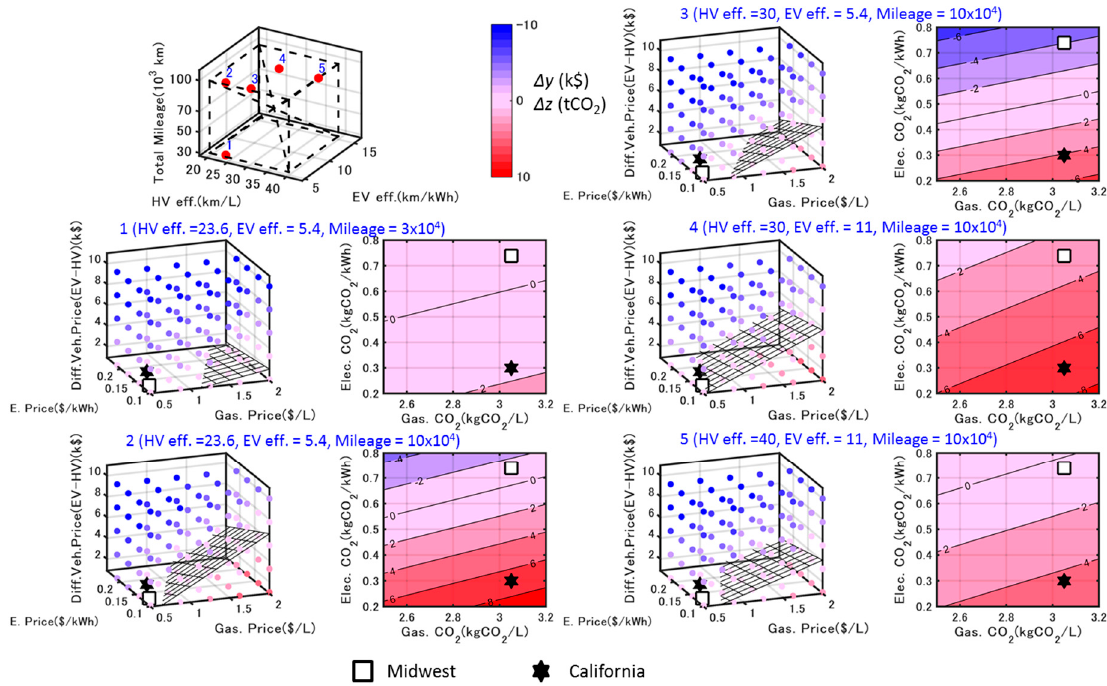
Figure 9. Eight-dimensional diagram representing specific regions showing the LCC and LCCO 2 comparisons between HV and EV under five different settings of fuel efficiency and total mileage travelled.